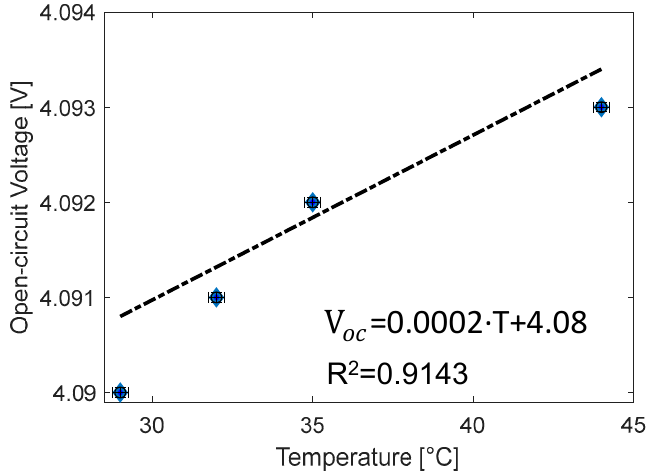
Figure 4. Determination of the coefficient of entropy of the battery calculated as the slope of the linear regression obtained from the experimental data.